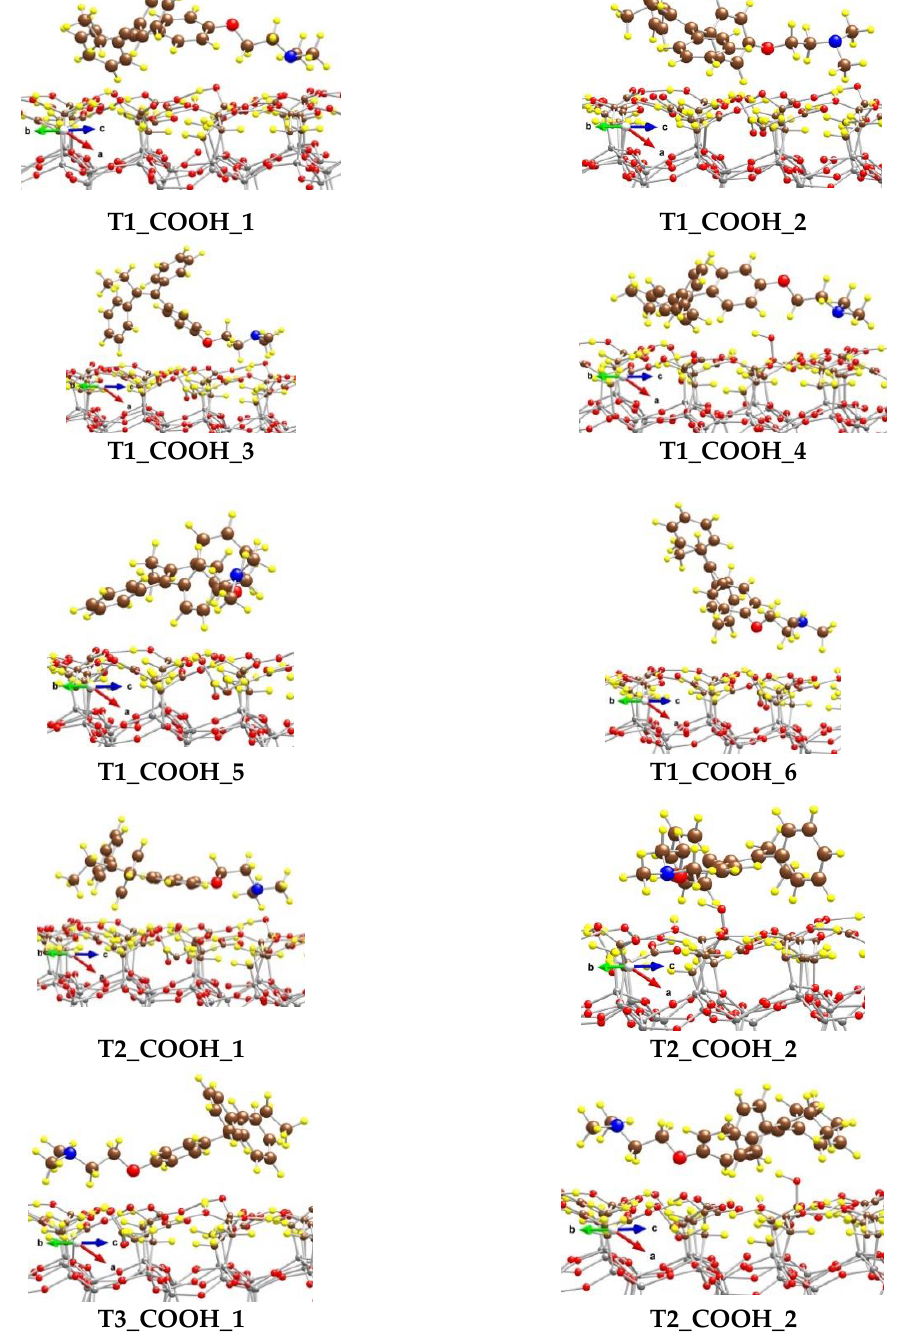
Figure 6. Optimized complexes of a tamoxifen molecule adsorbed on a (CH 2 COOH)-terminated silicate surface. Color coding: Si — gray, C — brown, O — red, N — blue, and H — yellow. For visual clarity the C and O centers from tamoxifen are represented with larger spheres.